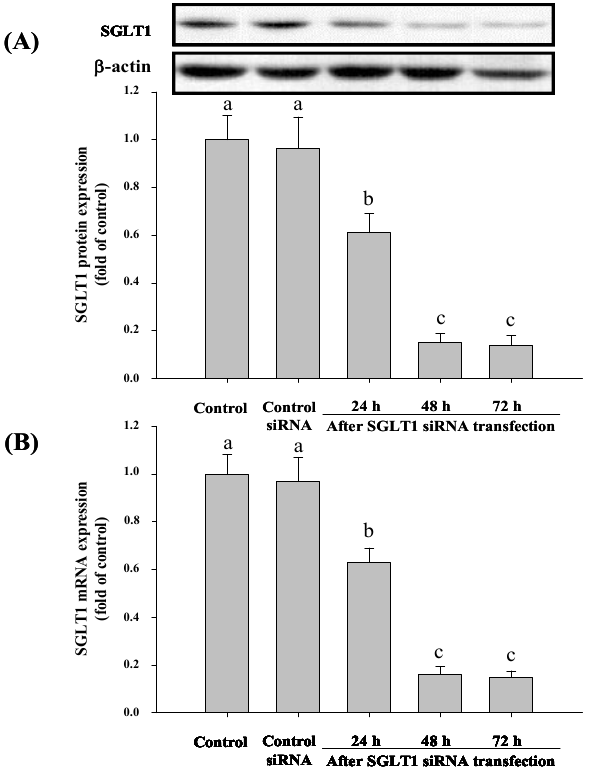
Figure 3. Expression of SGLT1 in Caco-2 cells after siRNA transfection. Caco-2 cells were treated with SGLT1 siRNA for 24, 48 and 72 h. Comparative expression of SGLT1 was then assessed by western blotting ( A ) and real-time PCR ( B ), respectively. Values without a common letter differ, p <